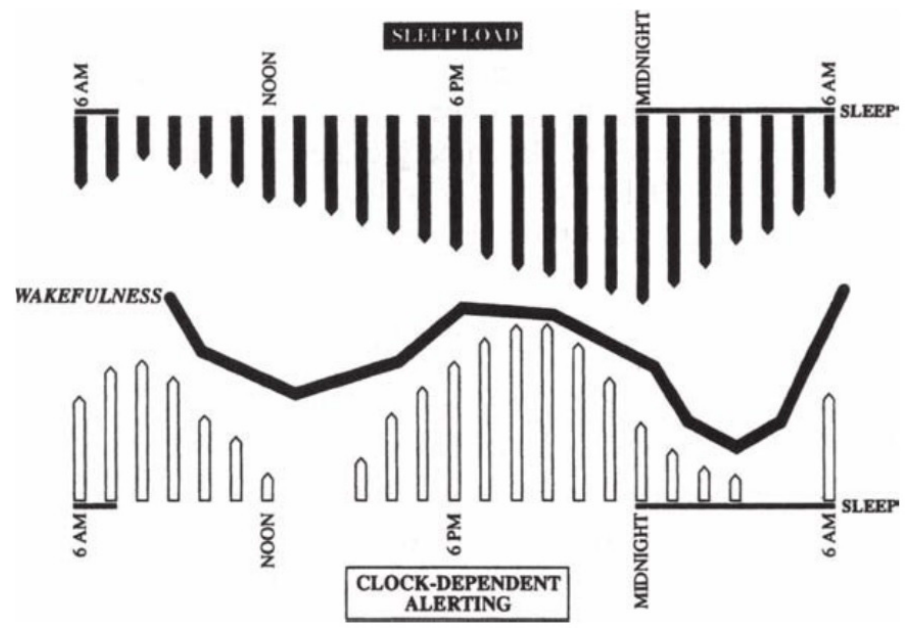
Figure 1. Normal distribution of sleep stages in healthy children, adults, and the elderly [6].